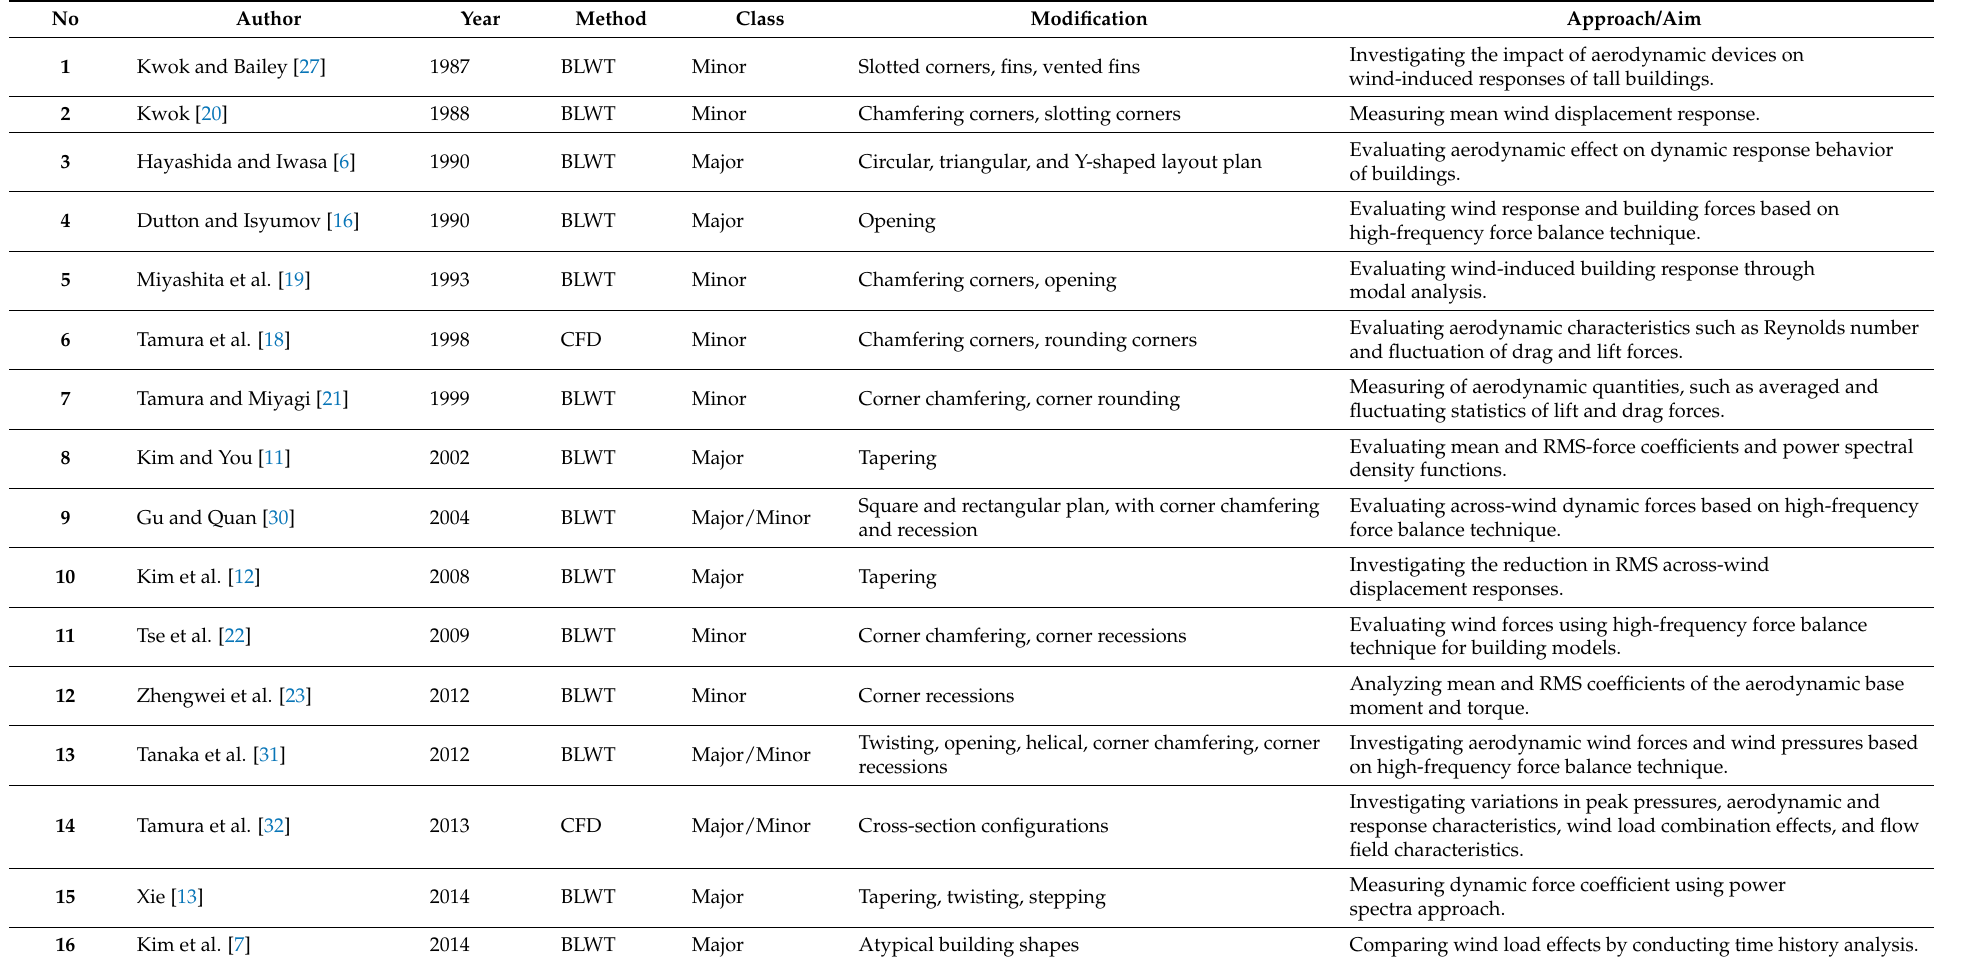
Table 1. Literature review